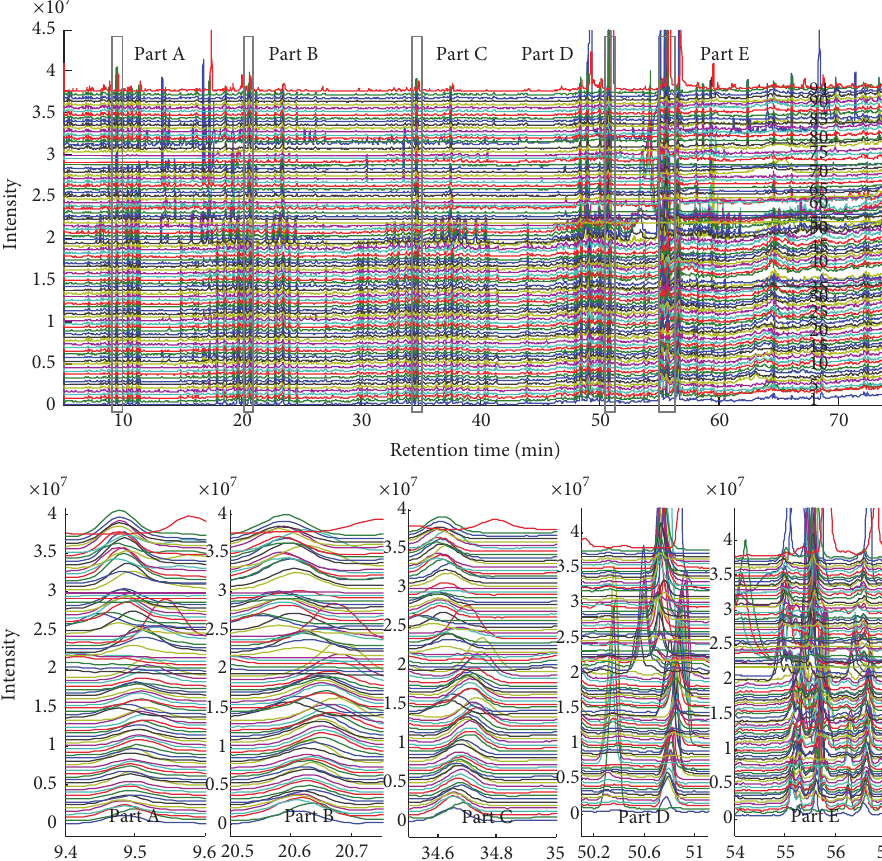
Figure 3: The 94 original metabolite profiles (TIC profiles of GC-MS data) of ginseng before alignment. The five figures from part A to part E correspond to the five elution windows and show the detailed